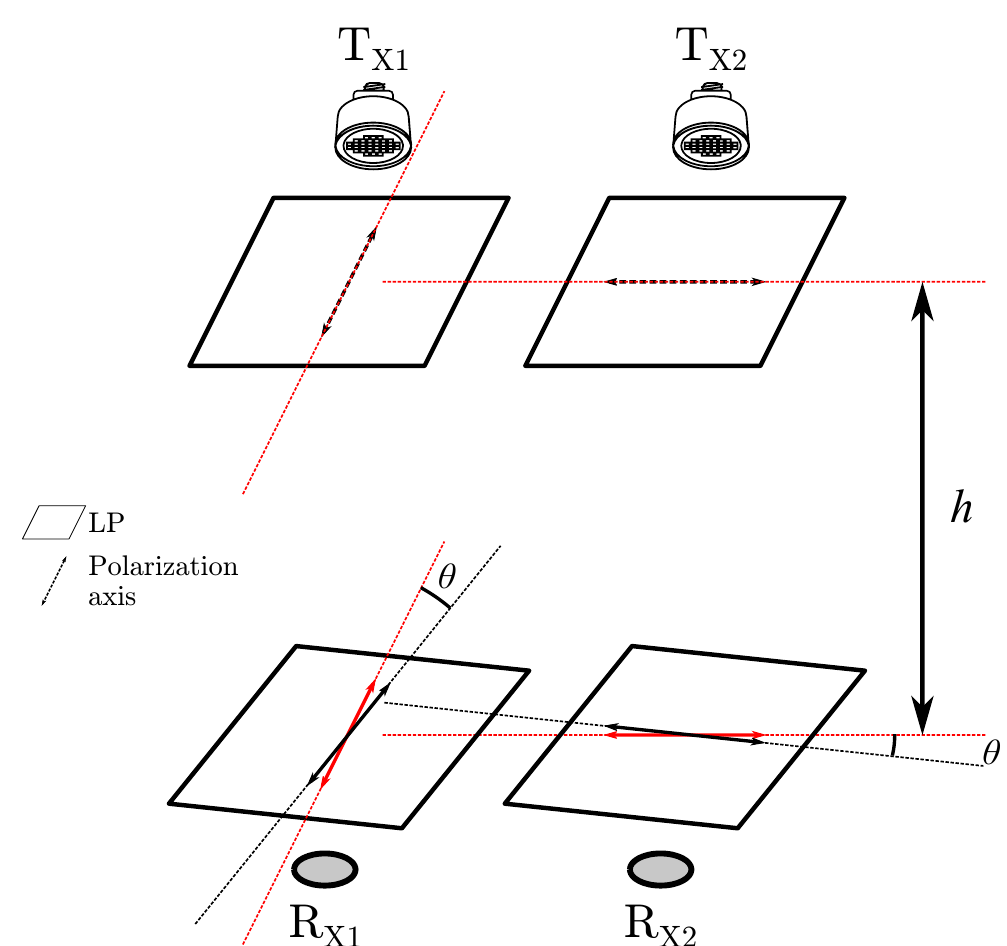
Figure 1. Setup consisting of two LEDs and two photodiodes, each equipped with mutually orthogonal linear polarizers (LP)